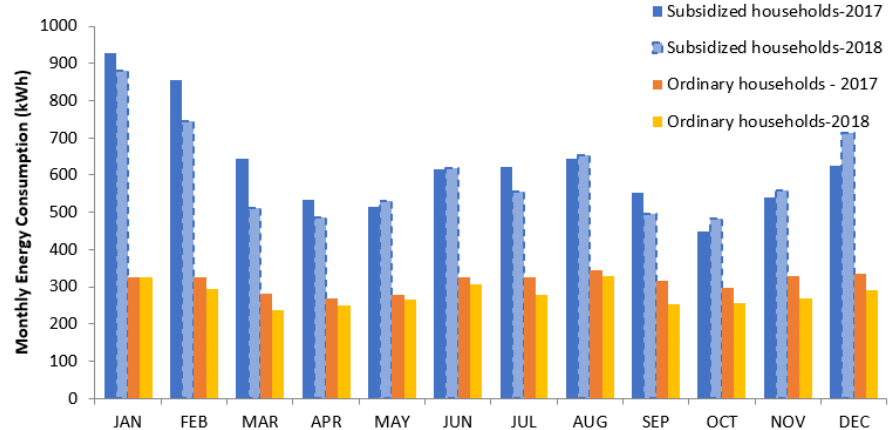
Figure 4. Monthly electrical energy consumption for ordinary and subsidised households over a two ‐ year period.